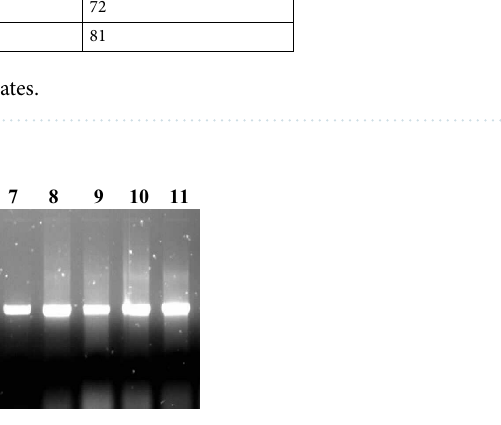
Figure 2. PCR product of the amplification of toxR gene for Vibrio genus. Confirmation. Lane 1 : Molecular weight marker (100 bp); lane 2: negative control; lane 3: positive control; lane 4–11 : Vibrio positive isolates (663